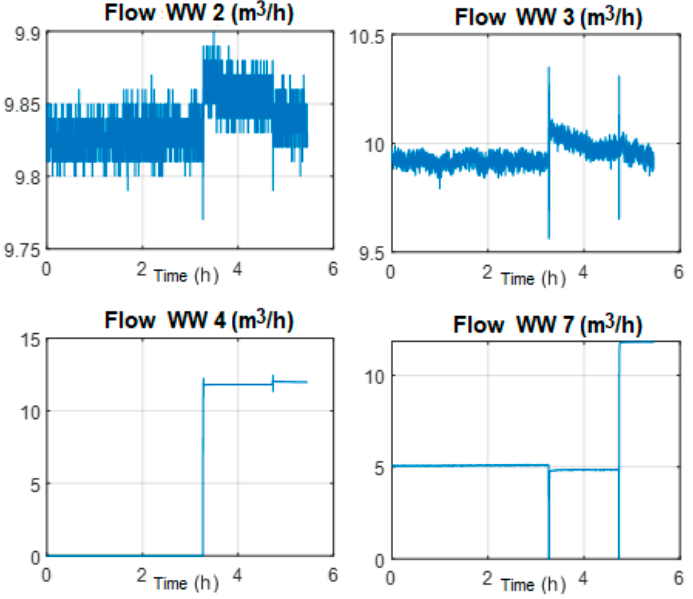
Figure 6. Example of flow evolution from the water wells with fixed setpoints.